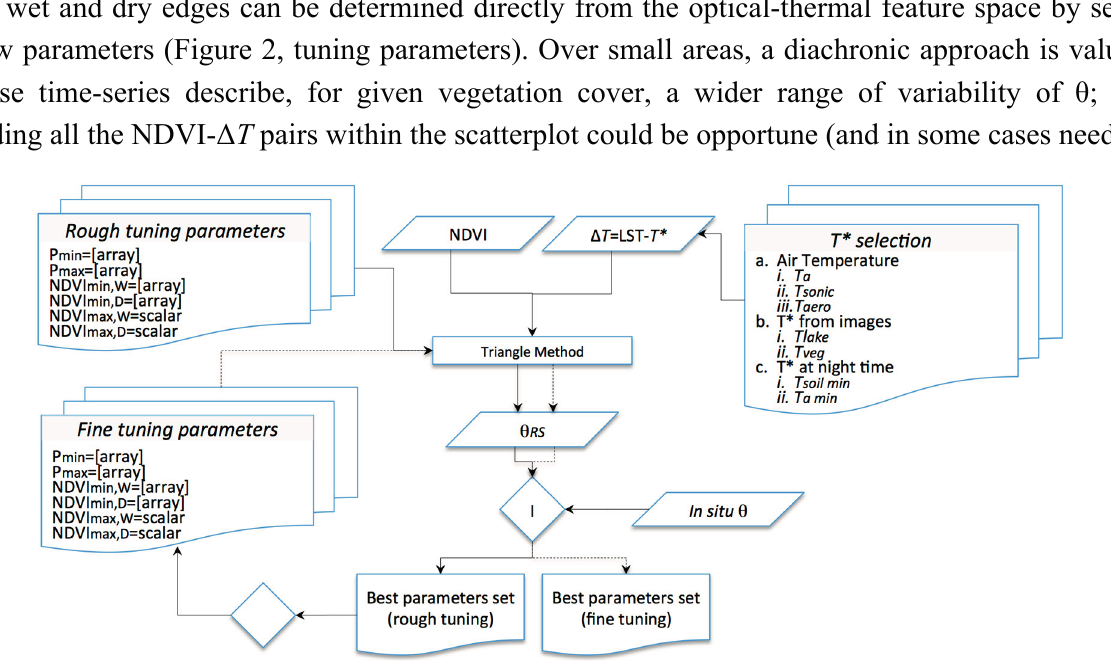
Figure 2. Flow diagram of the best fitting parameters procedure; dashed connectors indicate a fine-tuning